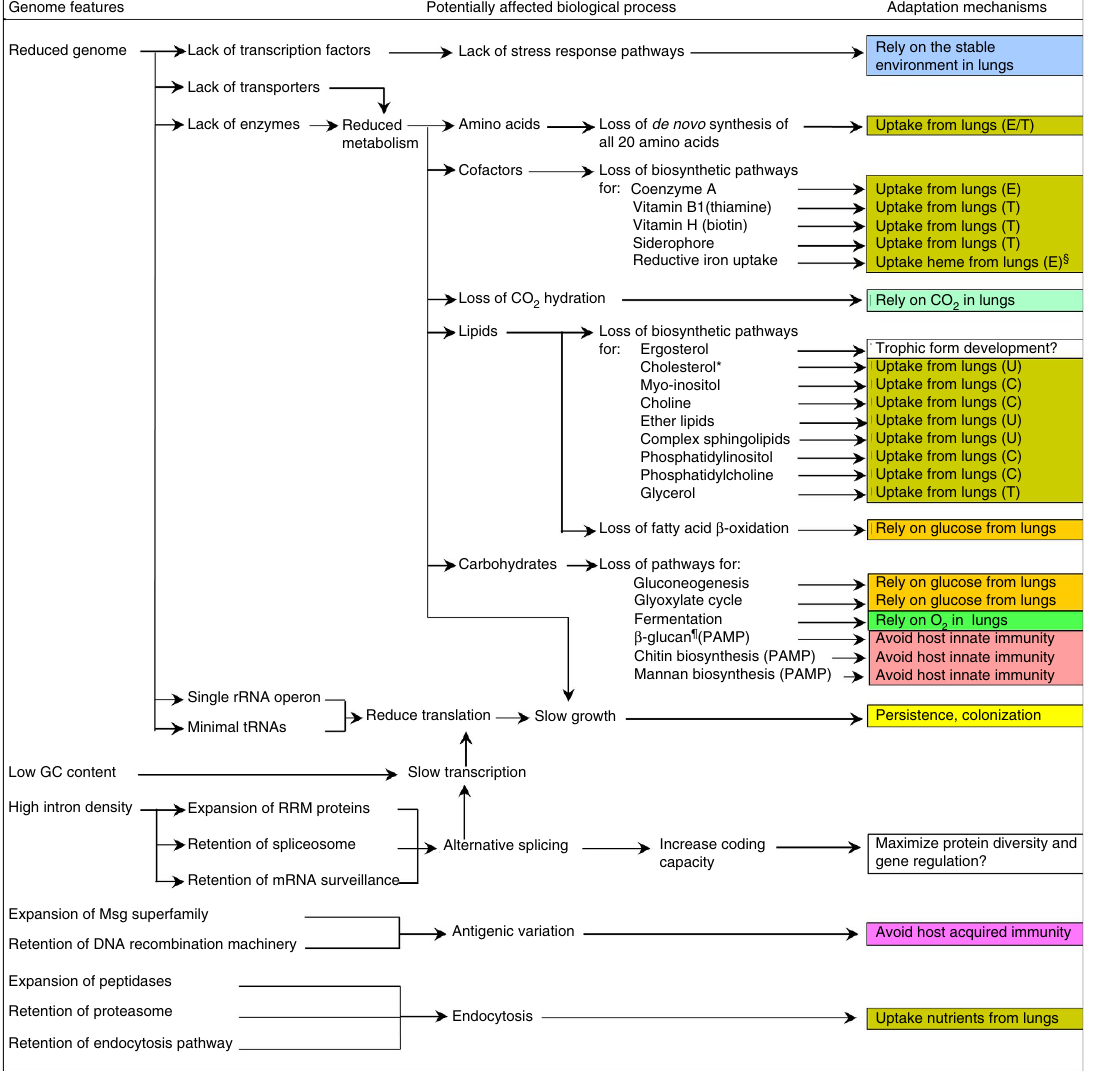
Figure 5 | Summary of mechanisms of adaptation to host lungs by Pneumocystis . Different mechanisms are highlighted by different colours. Potential mechanisms of uptake of nutrients (which cannot be synthesized de novo ) include the use of plasma membrane-localized transporters (indicated by T), conversion of other metabolites scavenged from hosts (indicated by C), endocytosis (indicated by E) and unknown (indicated by U). y Potential uptake of haem or haemoglobin from lungs by endocytosis mediated by CFEM domain-containing proteins. *Cholesterol biosynthesis pathway is retained in P. jirovecii but lost in P. murina and P. carinii . z b -glucan is present in cysts and absent in trophic forms. b -glucan as well as chitin and mannan in other fungal pathogens are known pathogen-associated molecular patterns (PAMP) involved in host immune recognition; none of these components is detected in Pneumocystis organisms except for the presence of b -glucan in the cyst form (Figs 6 and 7; Supplementary Fig. 13). Pneumocystis is the only fungus identified to date that cannot synthesize